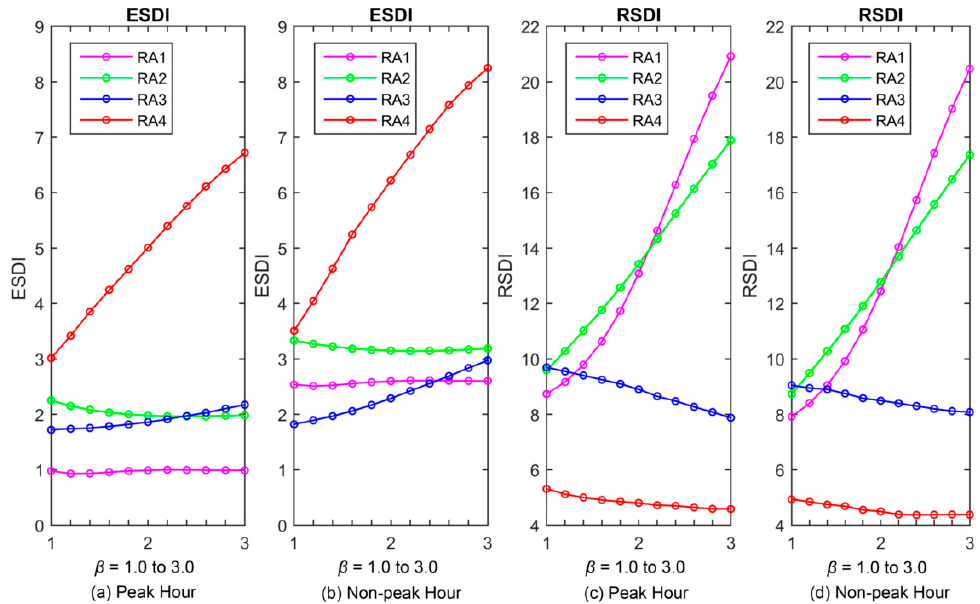
Figure 17. Variation of the average values of ESDI and RSDI under different β values of different ring areas.